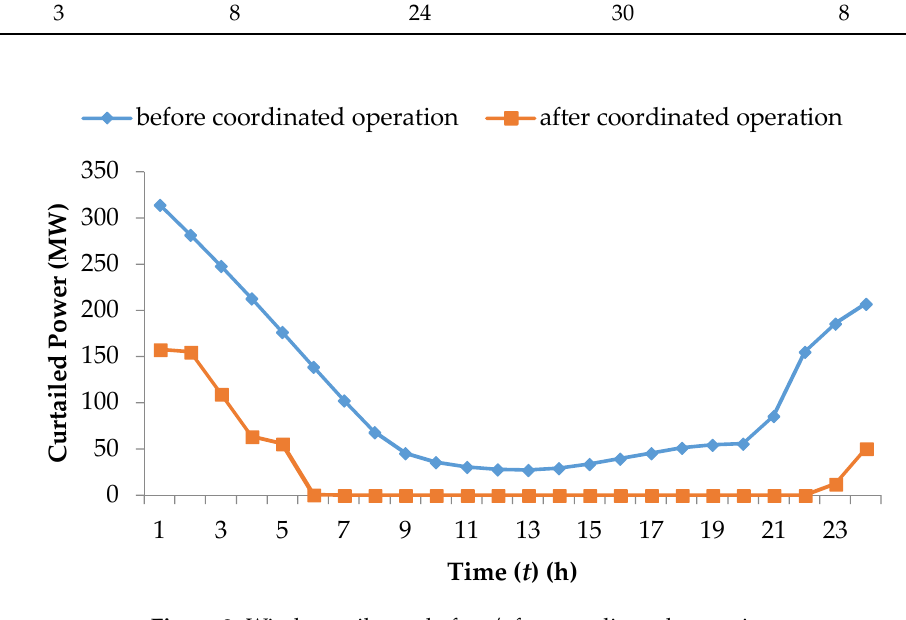
Figure 2. Wind curtailment before/after coordinated operation.